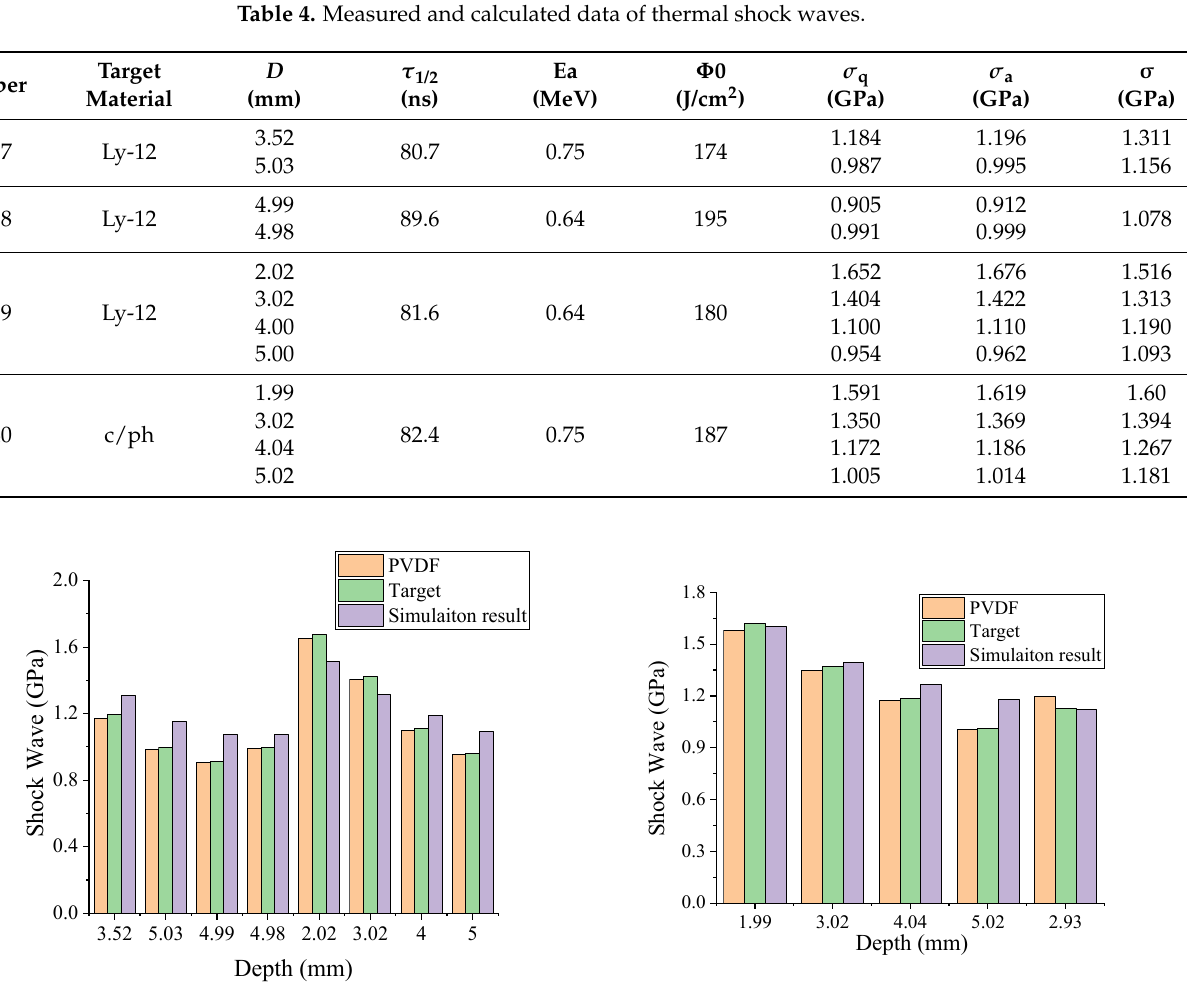
Figure 16. Measured and calculated results of thermal shock waves for aluminum and carbon phenolic materials.